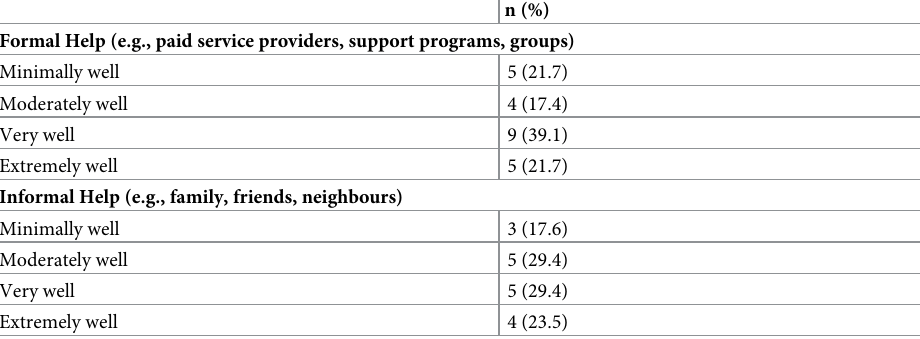
Table 2. How well caregivers’ needs were met for those who received formal help (n = 23) and informal help (n = 17).